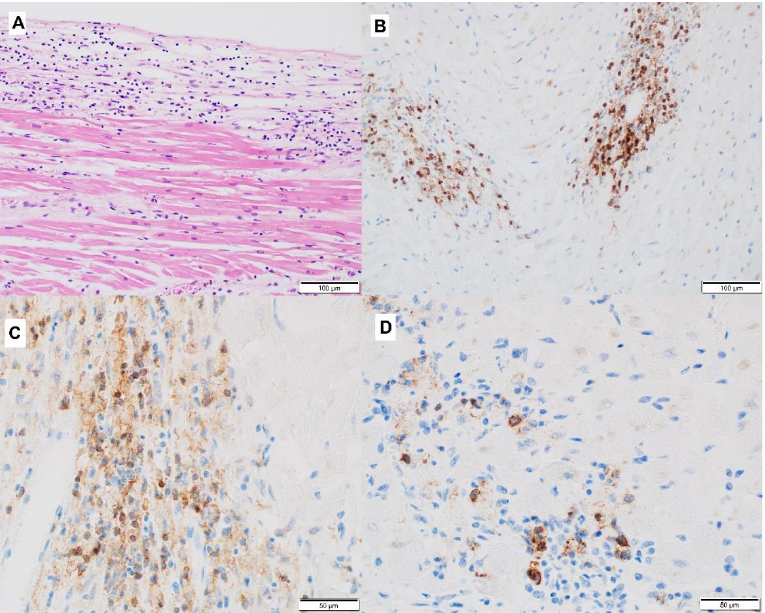
Figure 3. Histologic presentation of cardiotoxicity during nivolumab: H&E stain of the myocardium shows patchy lymphocytic infiltrates associated with myocarditis and myocyte damage ( A ); immunochemistry stain for CD3 ( B ), CD4 ( C ), and CD8 ( D ) highlights in brown T cells within the inflammatory infiltrate.